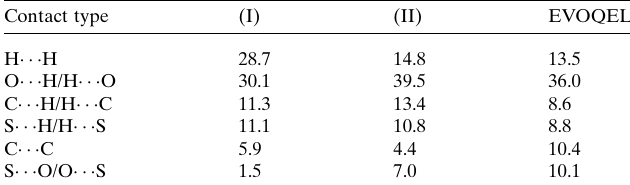
Table 3 Hirshfeld contact interactions (%).